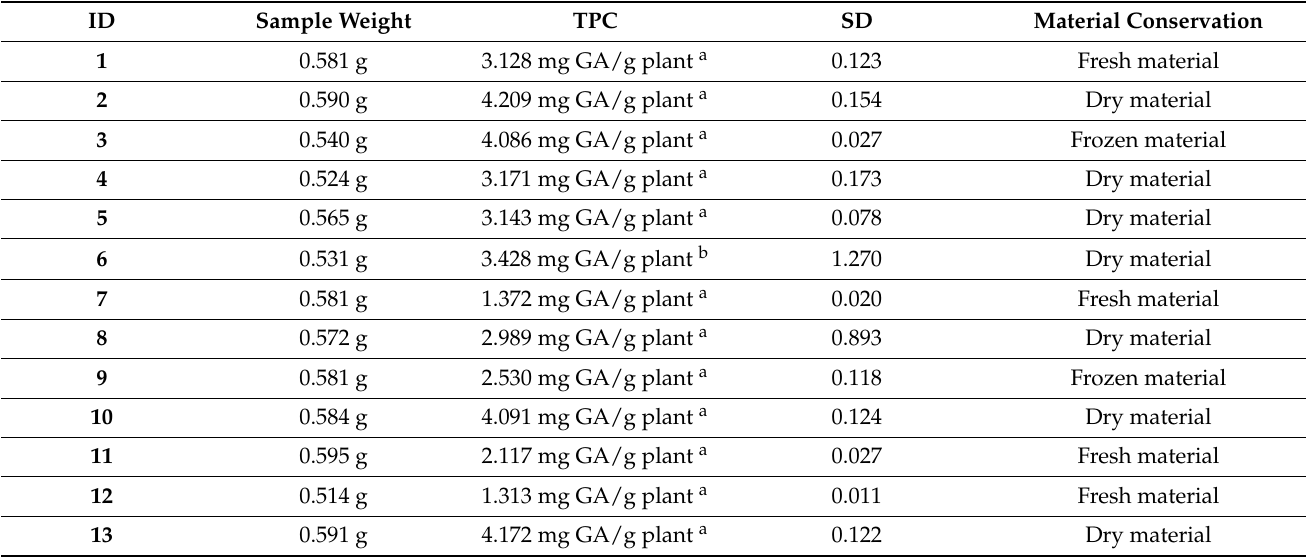
Table 3. Ratio of total phenolic compounds (TPC) determined by the Folin–Ciocalteu method. SD: standard deviation. For each column different superscript letters (a and b) mean statistically significant variations among